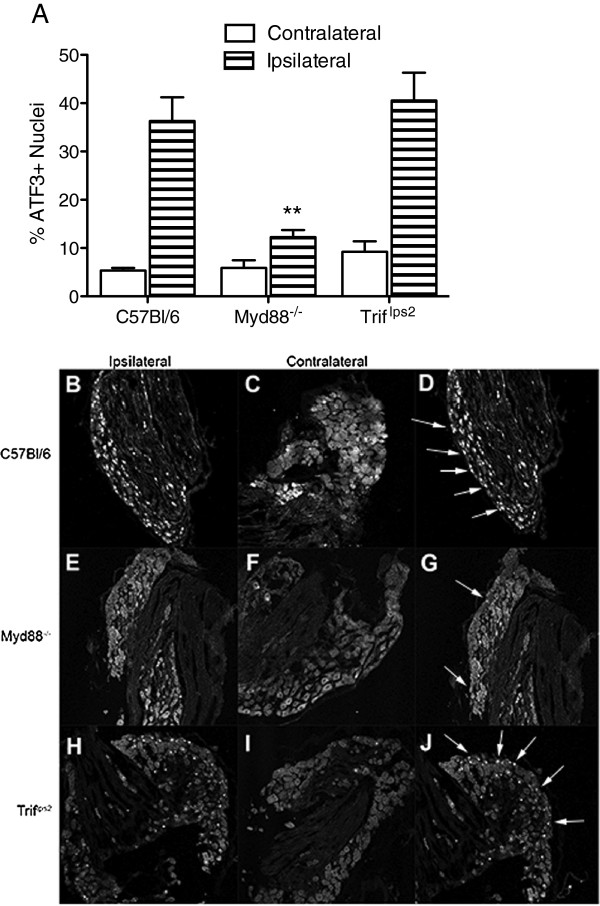
MyD88 signaling deficient mice have less ATF3+ nuclei following L5 SNL. At day 14 following L5 SNL, the ipsilateral and contralateral L5 DRGs were harvested and incubated with an antibody against ATF3. (A)Myd88-/- DRGs display less ATF3 immunoreactivity in their L5 ipsilateral DRGs when compared to C57BL/6. No significant difference was found among the other groups. Data expressed as mean ± SEM (n = 4–8 mice/group) and analyzed via 2-way ANOVA followed by Bonferroni post hoc test. The Myd88-/- ipsilateral group is statistically different from the C57BL/6 ipsilateral group (**P <0.01). Representative stained images from the DRGs of C57BL/6 (B-D), Myd88-/-(E-G), and Triflps2(H-J) mice are presented. Examples of ATF3+ nuclei are marked with a white arrow in D, G, and J.